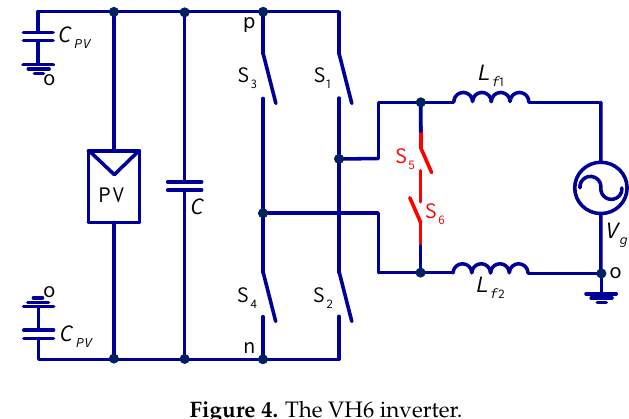
Figure 4. The VH6 inverter.